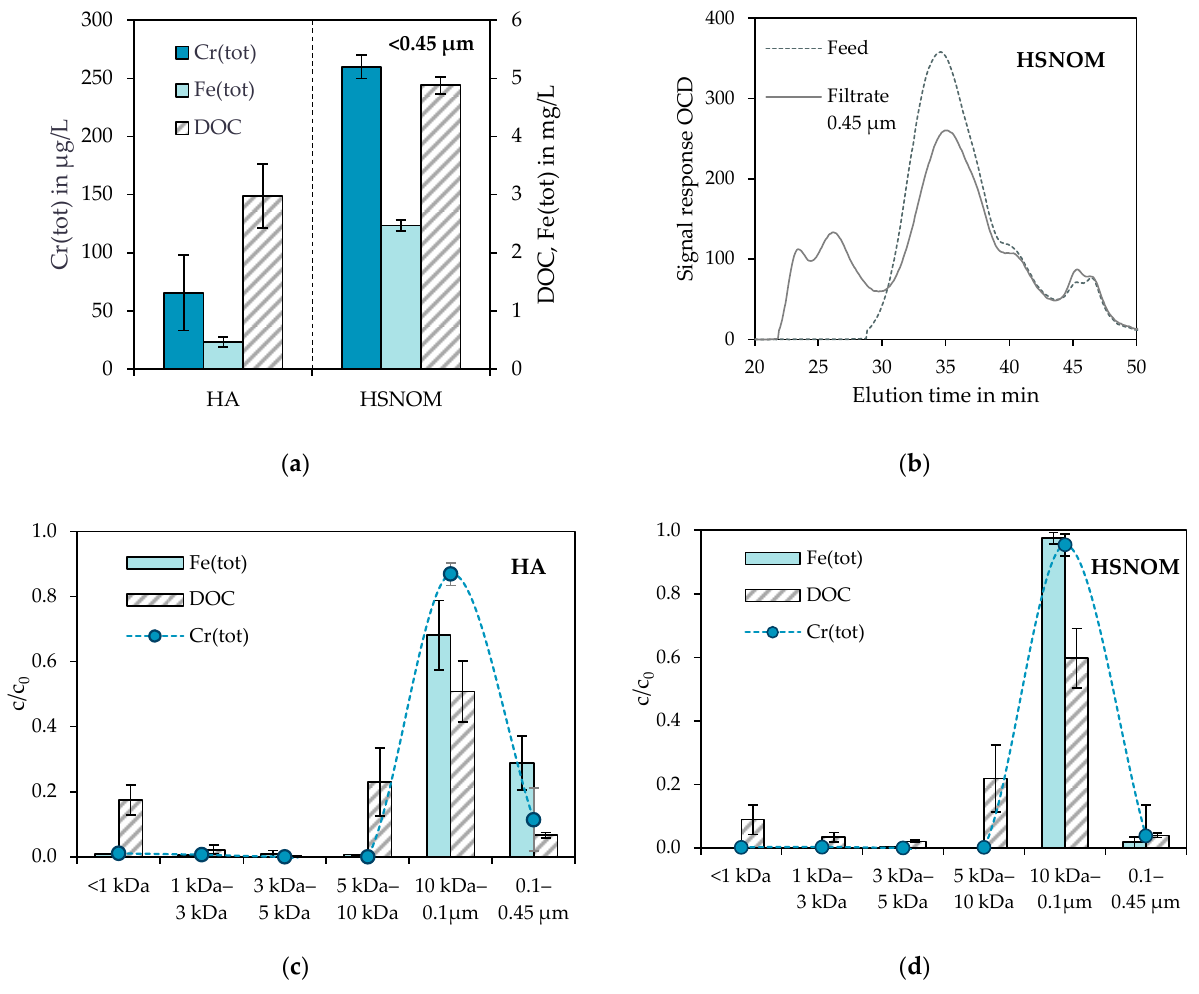
Figure 3. DOC fractionation experiments. Test conditions: 300 µg/L Cr(VI), 3.0 mg/L Fe(II), 5.5 mg/L DOC for humic acid (HA) or 4.7 mg/L DOC for “Hohlohsee” NOM (HSNOM), pH 7.5, t = 60 min, n = 2; error bars indicate minimum and maximum. ( a ): Mean absolute concentrations of Cr(tot), Fe(tot) and DOC after reduction, precipitation and filtration (0.45 µm), which equal c 0 in ( c , d ). ( b ) LC-OCD plot of the feed and the 0.45 µm filtrate from the reduced and precipitated water when HSNOM was present. ( c , d ): Mean distribution of Cr(tot), Fe(tot) and DOC for HA and HSNOM over different size fractions/filter sizes (related to concentration of precipitated and filtered (0.45 µm) water).